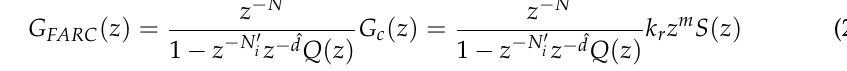
Figure 9. Trajectory of G F ( e jwTs ) with different k r.